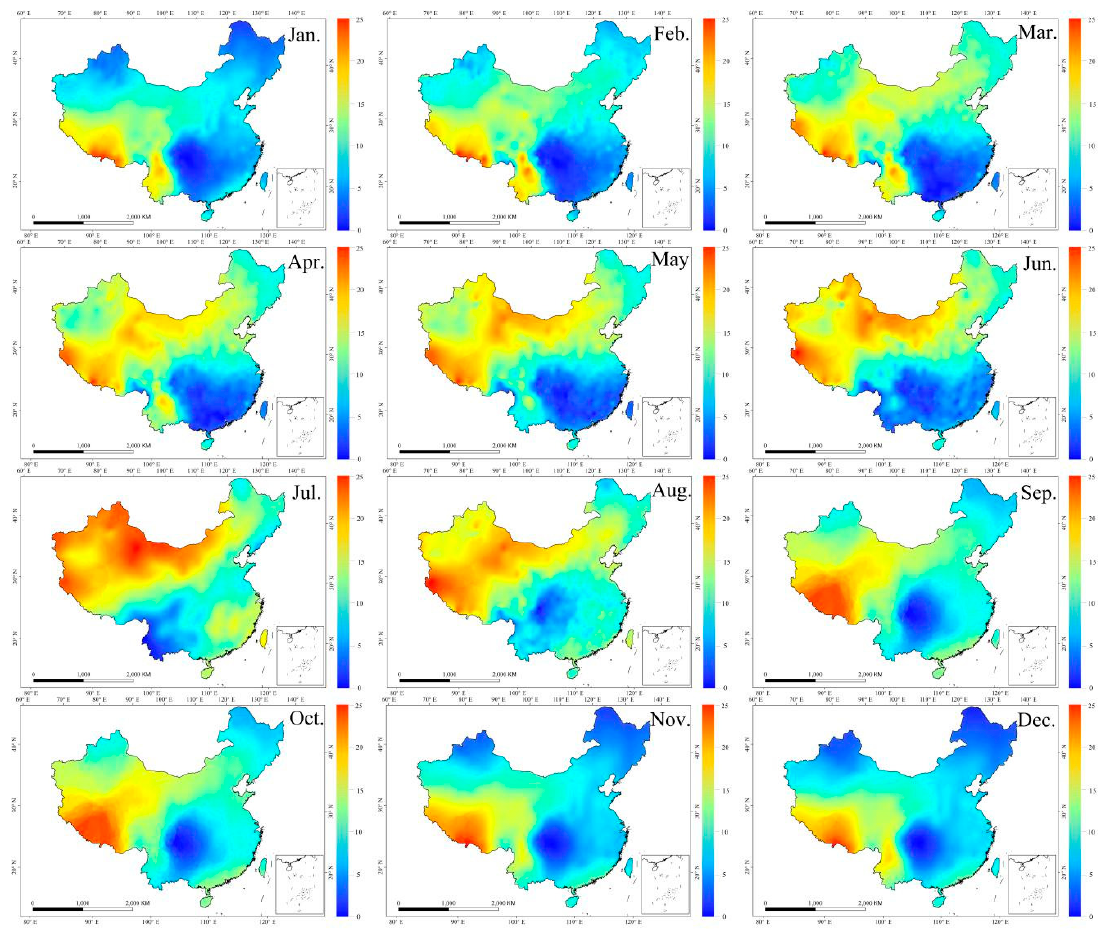
Figure 10. Spatial and temporal changes of DHI (MJ m − 2 day − 1 ) across mainland China